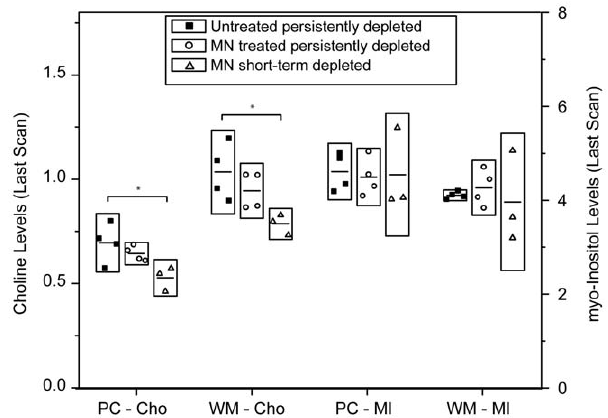
Figure 5. Minocycline reduces elevation of choline, not myo- Inositol. Choline concentrations (left) and myo-Inositol concentrations (right) in the PC and WM at the time of the last MRI scan comparing the three cohorts. Cho concentrations are significantly different among the three cohorts in the PC (p=0.033) and WM (p=0.035) by ANOVA. Cho levels are significantly lower in MN-treated, short-term CD8-depleted animals (PC p=0.01 and WM p=0.012) compared to untreated animals. Differences in MI concentrations at the last MR scan were not statistically significant among the three cohorts by ANOVA. Horizontal bars within boxes represent mean values; height of each box correspondstoafactorof1.5timesstandarddeviation.*indicatesa significantdifference(p # 0.05)betweengroups.